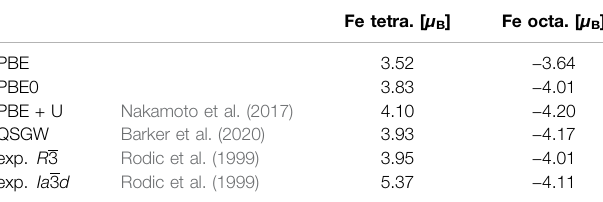
TABLE 1 | The magnetic moments within the different muf fi n-tins ofboth Fe types in units of μ B